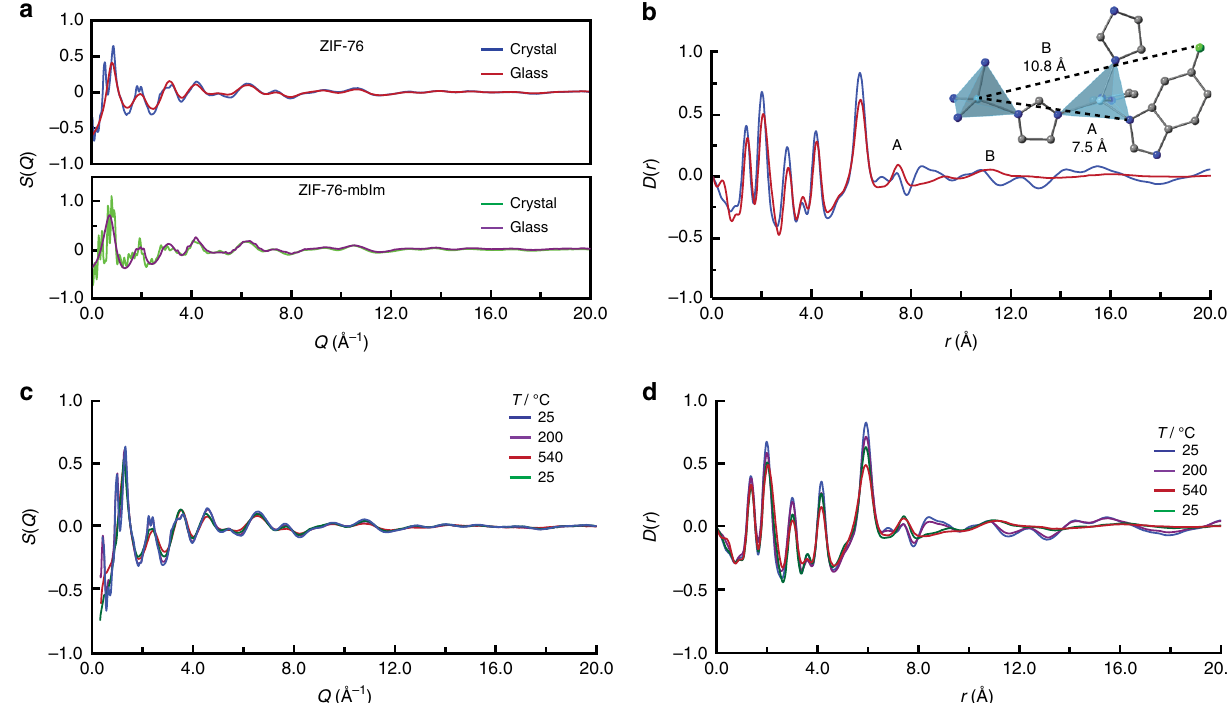
Fig. 3 Diffraction in the crystalline and glass states. a X-ray structure factors S ( Q ) of crystalline ZIF-76 and ZIF-76-mbIm, along with the corresponding glass samples. b Corresponding ZIF-76 pair distribution function D ( r ). Inset shows medium range order. Zn light blue, Cl green, C grey, N dark blue, H omitted for clarity. c , d X-ray structure factors S ( Q ) and pair distribution functions D ( r ), respectively, of ZIF-76 upon heating and subsequent recovery to room temperature (green curve at 25 o